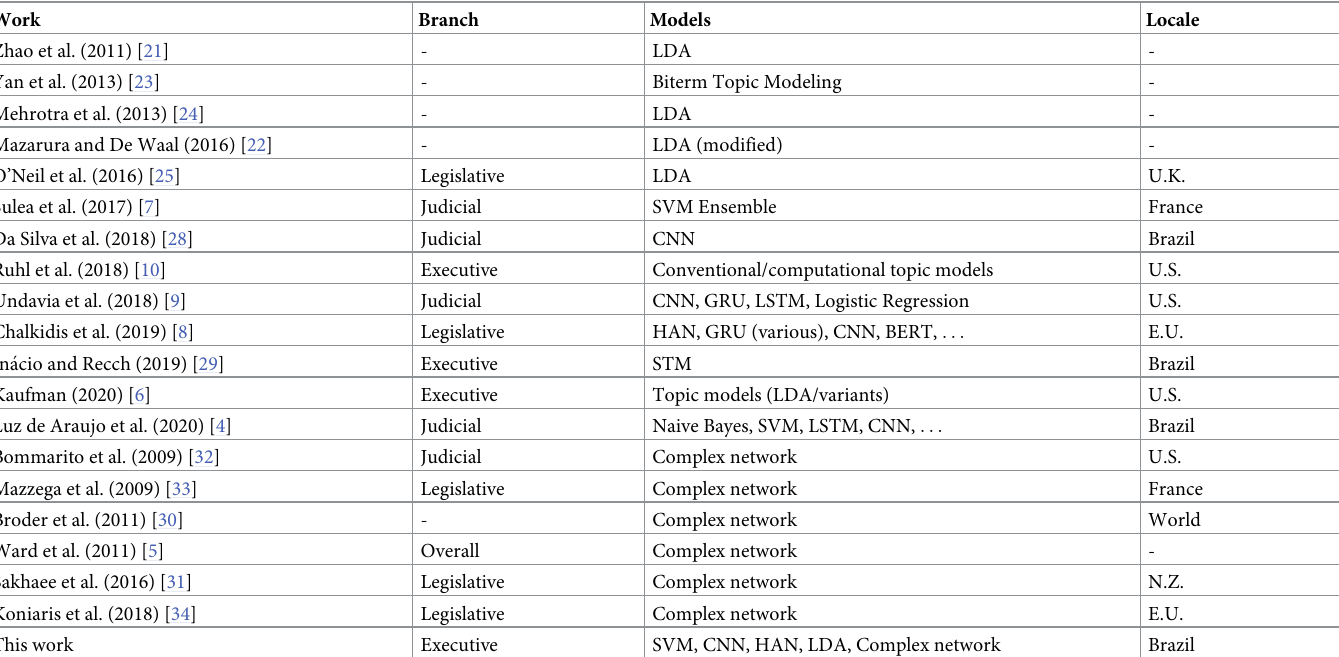
Table 1. Related